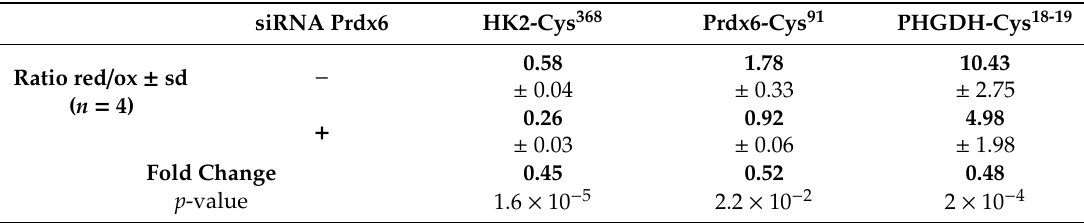
Table 1. Reversible thiol redox changes in specific sensitive